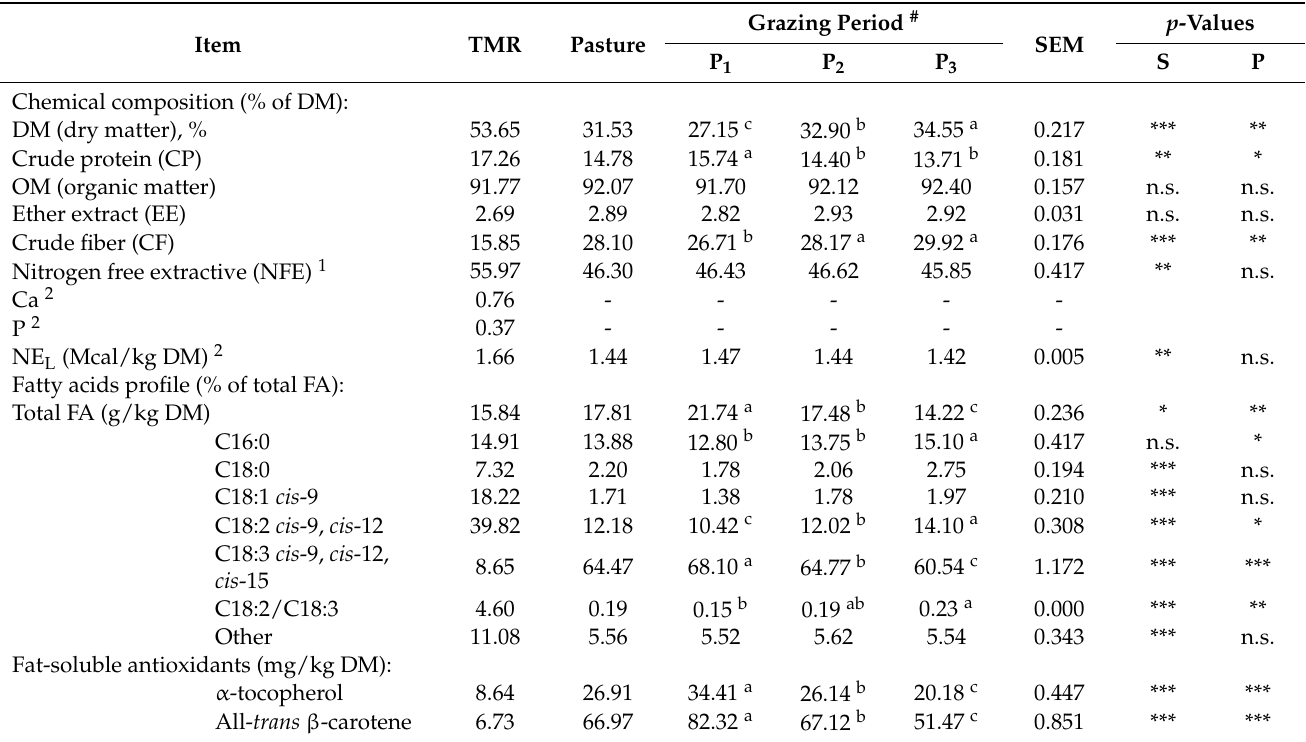
Table 1. Chemical composition, fatty acid profile and fat-soluble antioxidants content of TMR and pasture in the different trial